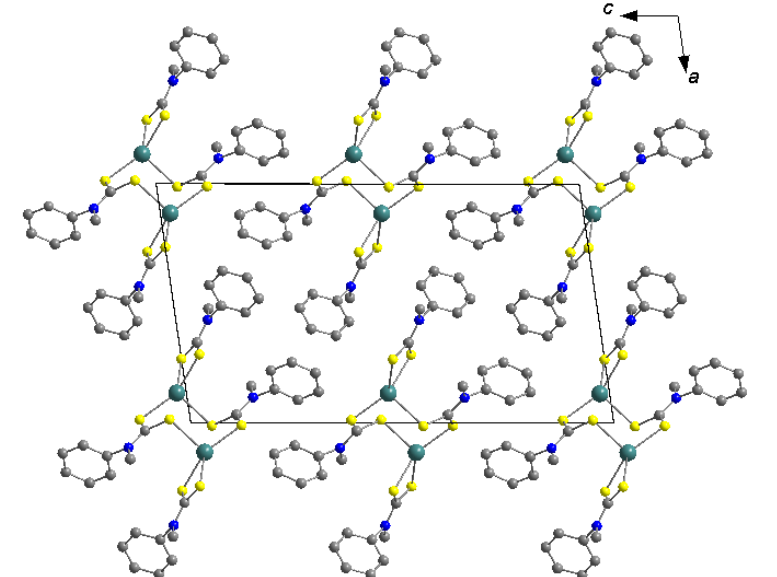
Figure 6. Packing diagram of [(C crystallographic b axis.